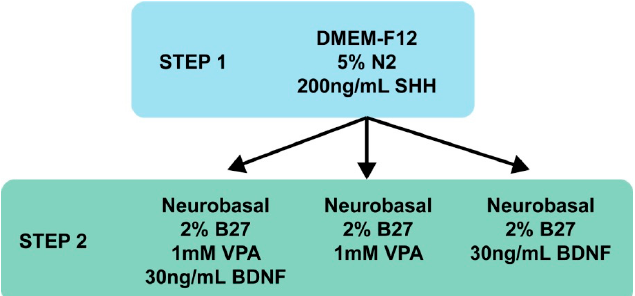
Figure 1. Media tested for the GABAergic differentiation of marrow-isolated adult multilineage inducible (MIAMI) cells.